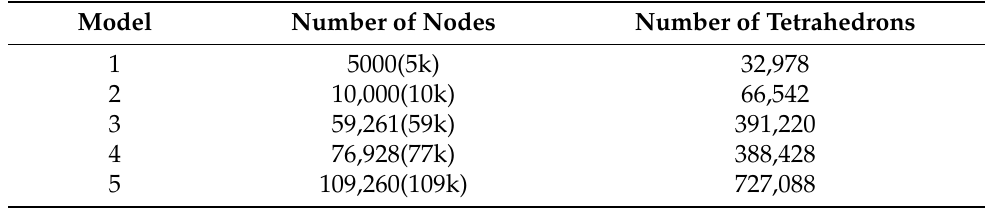
Table 2. Experimental